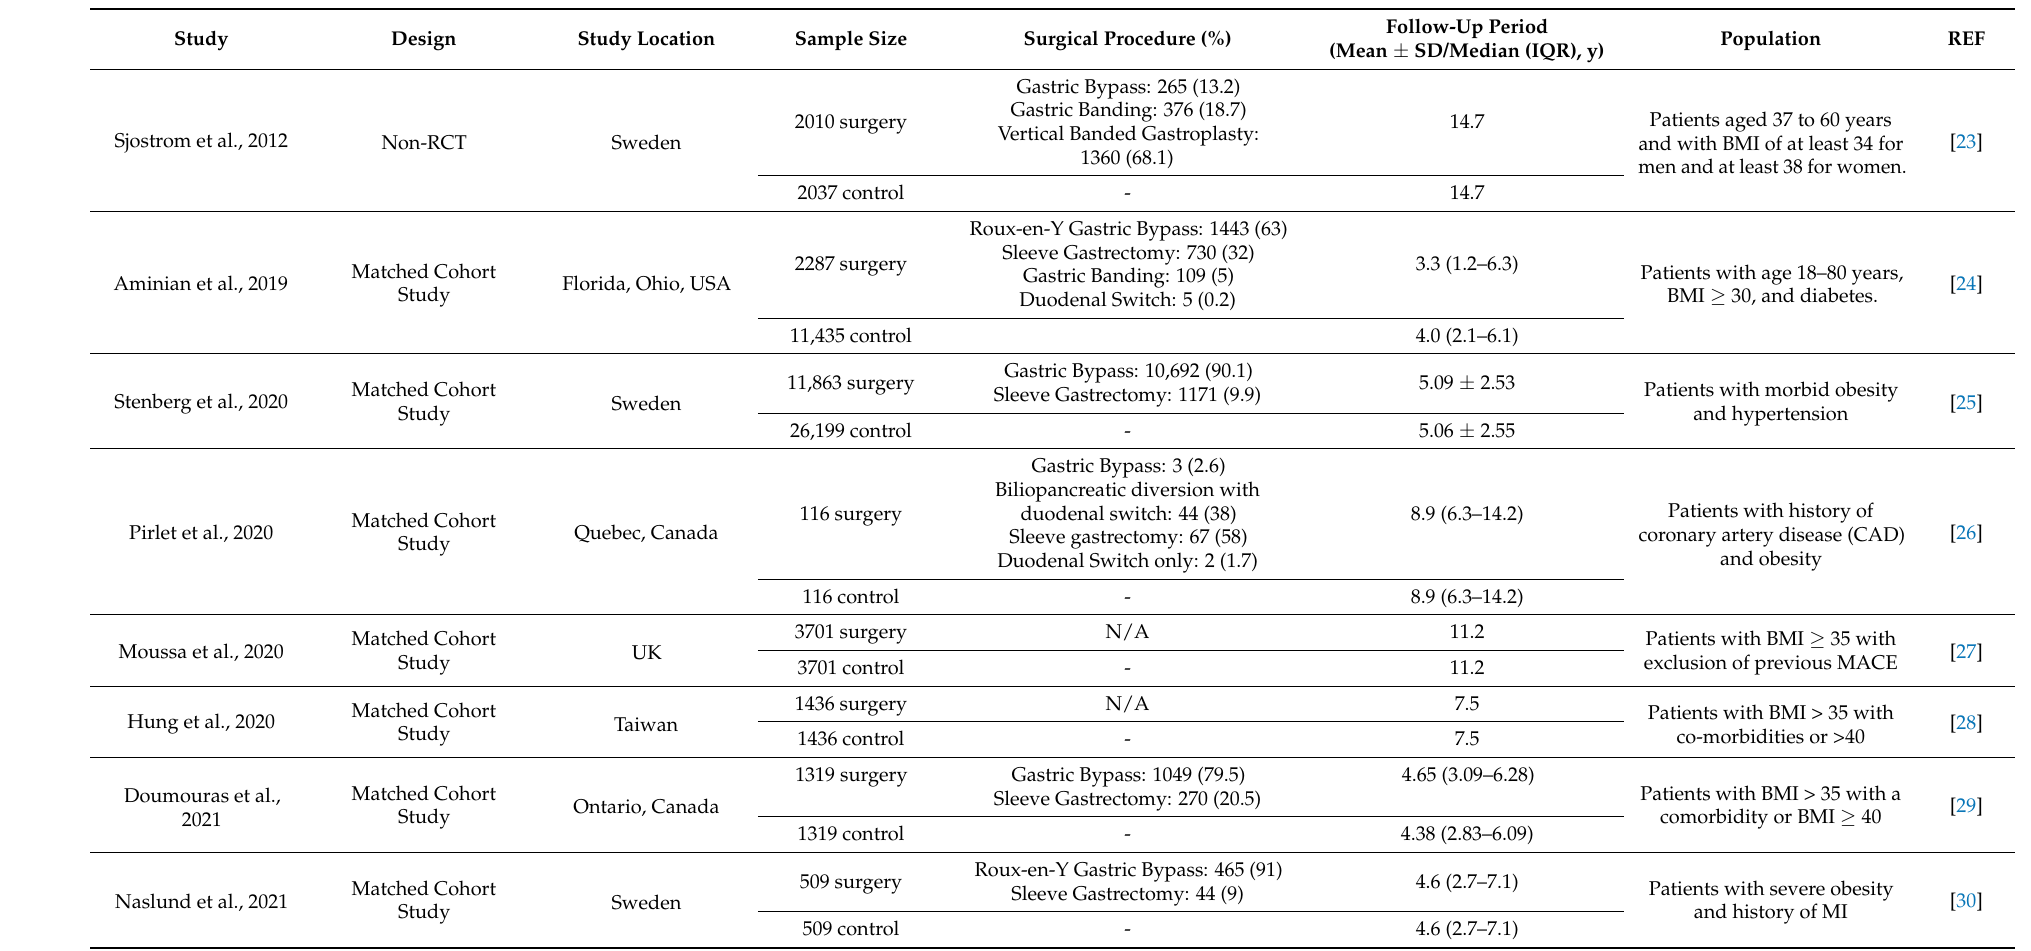
Table 1. Characteristics of the included